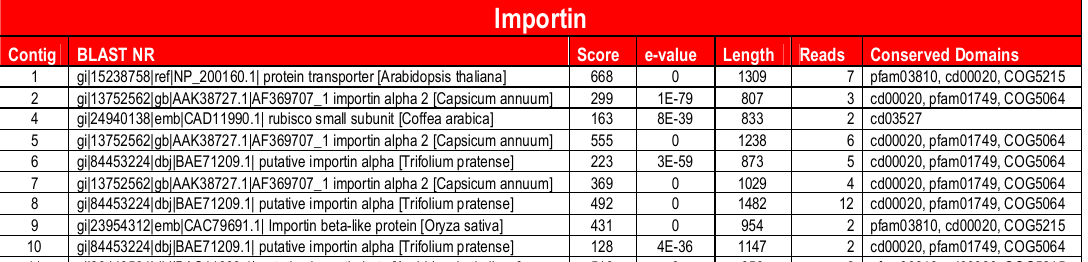
Table S13: EST-Contigs with e-value < e -20 and score > 100 obtained in the Project Importin, and their blast hit, score, e-value, size, number of reads, and conserved domains from putative